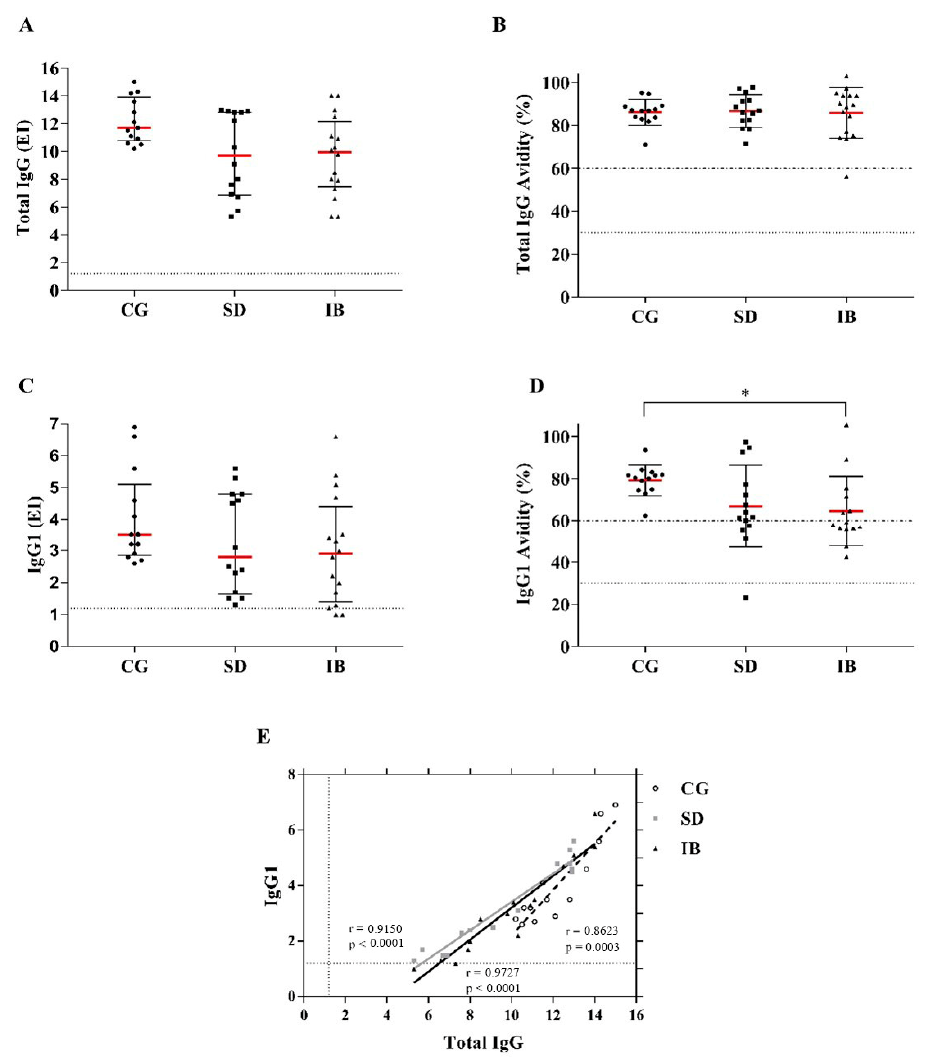
Figure 2. Evaluation of humoral immunity, assessed by the production of specific antibodies to Toxoplasma gondii. ( A ) Levels of total IgG anti- T. gondii antibodies, expressed in ELISA index (IE). ( B ) Avidity index of total IgG anti- T. gondii antibodies, expressed as a percentage (%). ( C ) Level of the IgG1 subclass anti- T. gondii , expressed in ELISA index (IE). ( D ) Avidity index of the IgG1 subclass anti- T. gondii , expressed as a percentage (%). ( E ) Correlation between the levels of total IgG antibodies and the IgG1 subclass, in groups CG, SD, and IB. Analysis among the groups by Kruskal–Wallis ( A , C ) and by ordinary one-way ANOVA ( B , D ), and correlation analysis by Spearman test, where r expresses the correlation coefficient. The horizontal bars represent the medians with interquartile ranges or means with standard deviation. Statistically significant data, * p < 0.05.